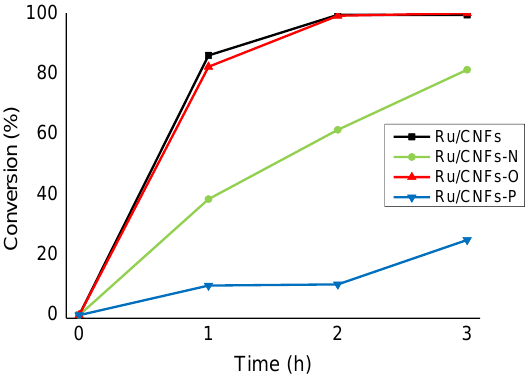
Figure 4. Change in activity in the HMF hydrogenation reaction on the different catalysts tested. Reaction conditions: HMF, 0.08 M, substrate/metal = 100 mol/mol, solvent, 15 mL 2-butanol, 150 °C, and 20 bar H 2 .